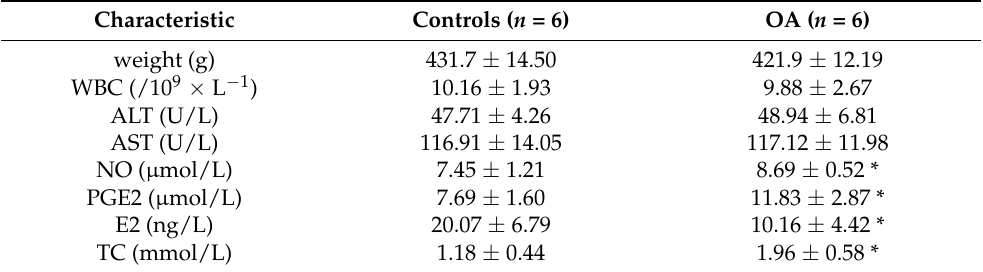
Table 1. Comparison of blood index and biochemical index between control group and OA group.